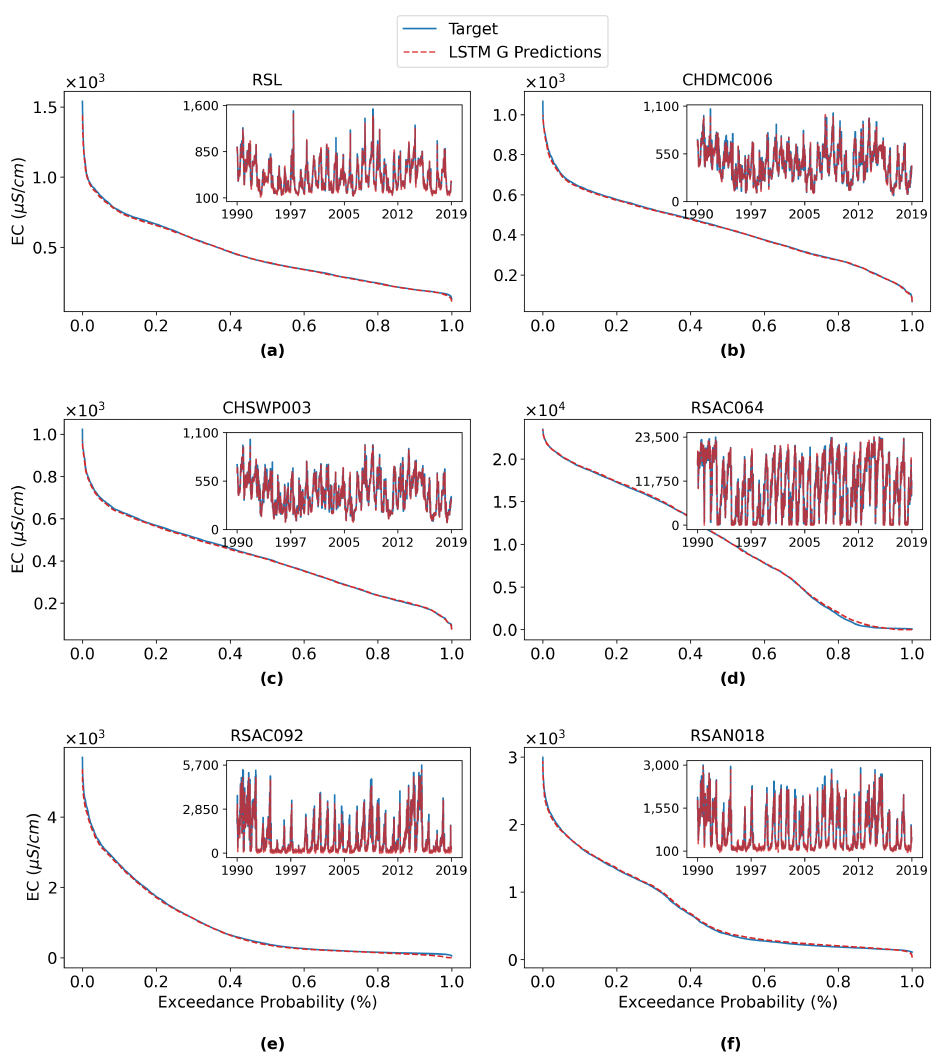
Figure 10. Exceedance probability curves and time series plots of salinity at six key study locations, including ( a ) RSL, ( b ) CHDMC006, ( c ) CHSWP003, ( d ) RSAC064, ( e ) RSAC092 and ( f ) RSAN018, comparing the grouped LSTM model with the process-based DSM2